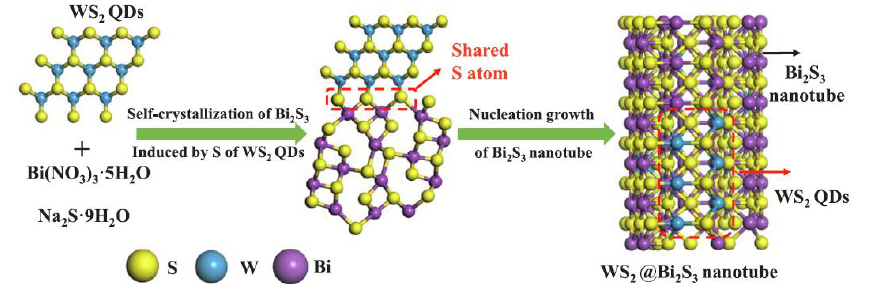
Figure 5. Schematic illustration of the structure of WS 2 QD/Bi 2 S 3 . Reproduced with permission from reference [57].